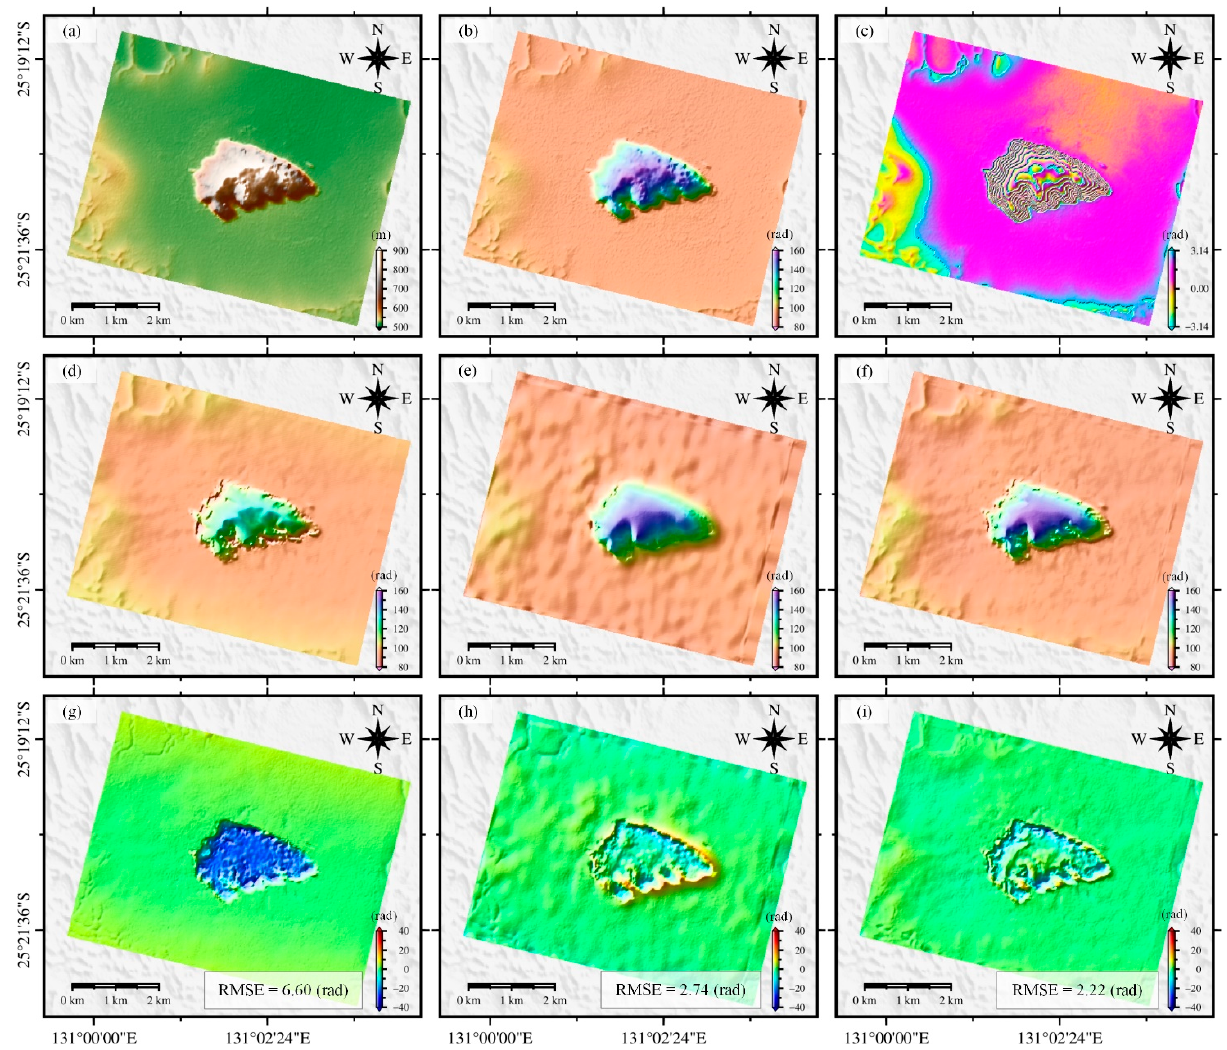
Figure 4. Performance comparisons of the conventional InSAR, RSSI, and RID methods based on the realistic TerraSAR-X data set: ( a – c ) represent the Copernicus DEM, unwrapped phase converted from the Copernicus DEM, and rewrapped phase converted from the Unwrapped phase, respectively; ( d – f ) show the reconstructed DEM phase using the conventional InSAR, RSSI, and RID methods, respectively; ( g – i ) present the differences between ( b ) and ( d – f ).